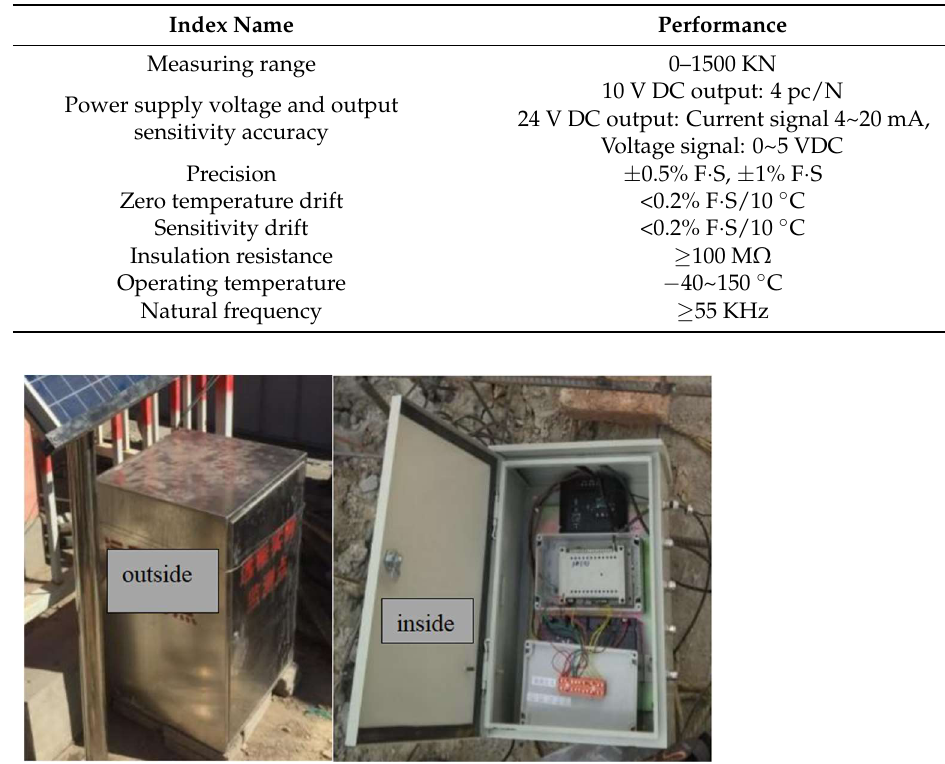
Figure 4. Data acquisition module.